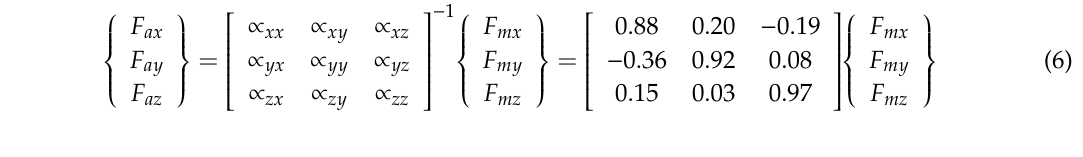
Table 2. Crosstalk Results from Finite Element (FE)